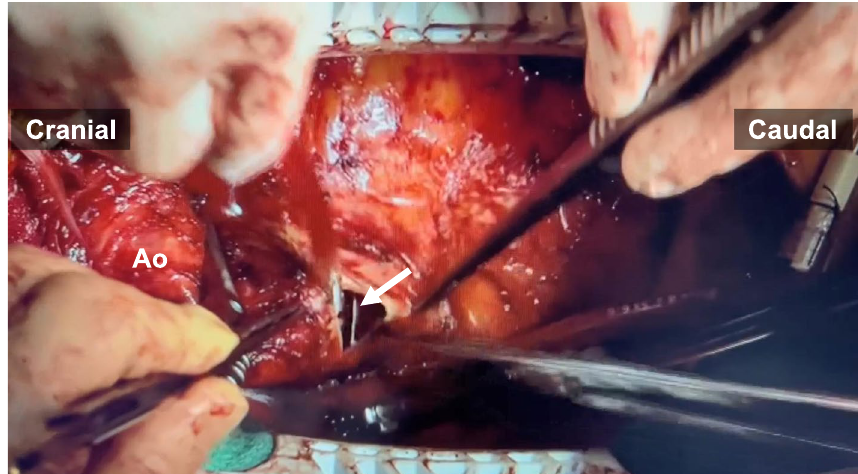
Fig. 3 Image of the surgical field. The tip of the left ventricular vent was in the aortic root (white arrow), which was withdrawn to the left ventricular cavity under direct vision. Ao, ascending